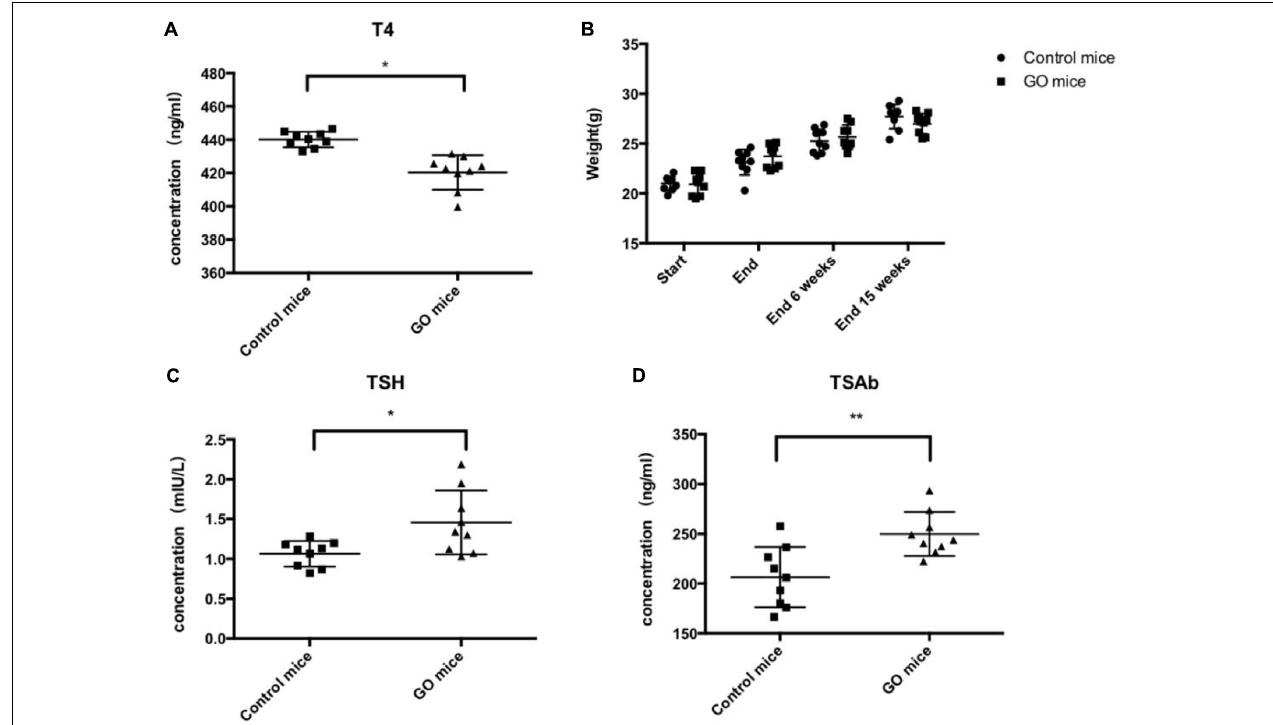
FIGURE 2 | Thyroid function and Antibody. (A) control mice and GO mice total serum T4 values; (B) control mice and GO mice killed at 6 and 15 weeks after end of immunization; (C) control mice and GO mice total serum TSH values; and (D) control mice and GO mice total serum TSAb values. * P value < 0.05 compared with control group; ** P value < 0.01 compared with control